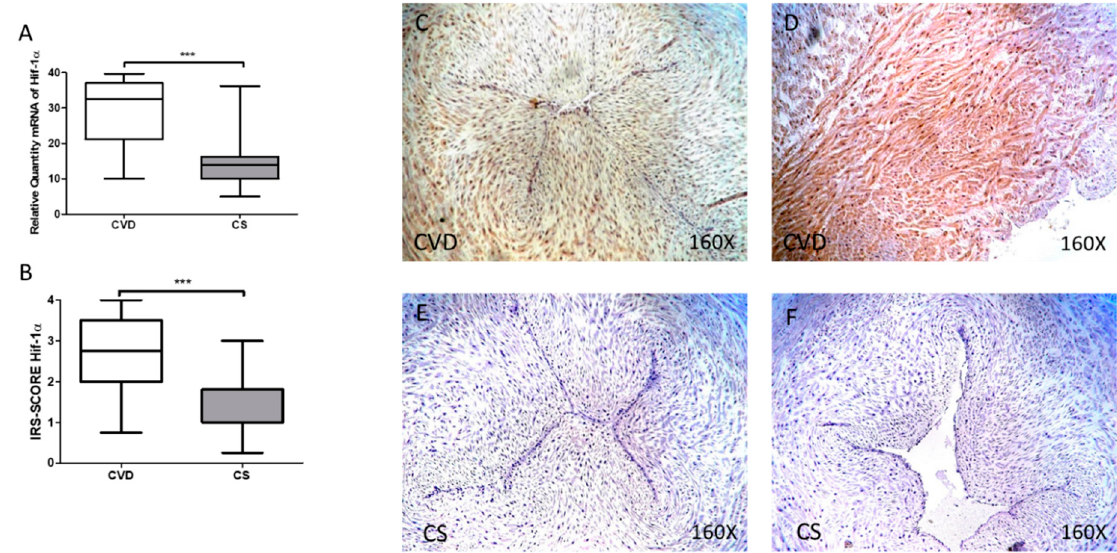
Figure 1. ( A ) mRNA expression levels for Hif-1 α by RT-qPCR in the umbilical cord. ( B ) Levels of IRS-SCORE in the umbilical cord. ( C – F ) Images showing the immunoexpression of Hif-1 α in the umbilical cord. CVD = Newborns of women diagnosed with chronic venous disease during pregnancy. CS = Control without venous pathology. p < 0.001 (***).